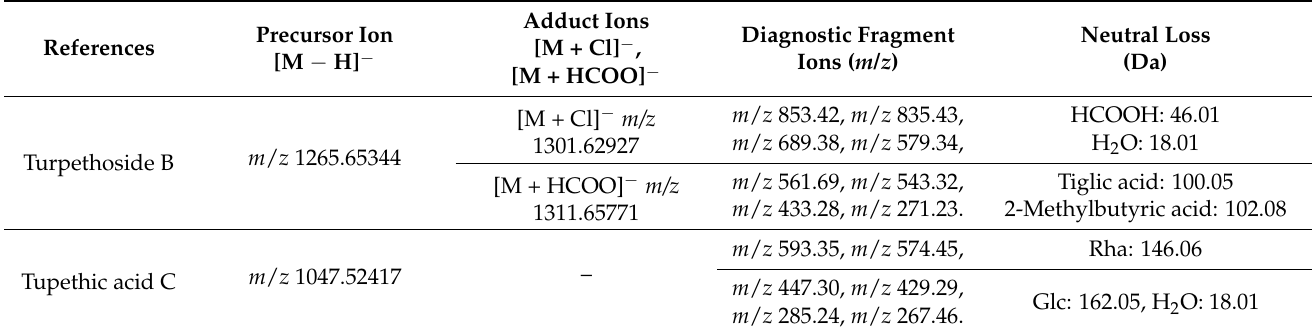
Table 1. A summary of key NL and DFIs for structure